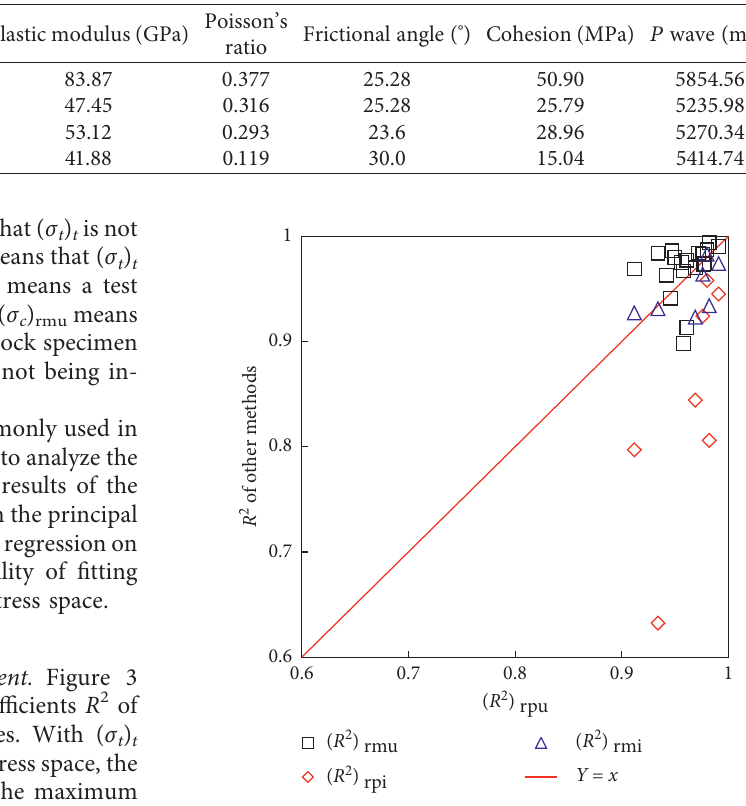
Table 2: Summary of mechanical parameters of marble specimens.